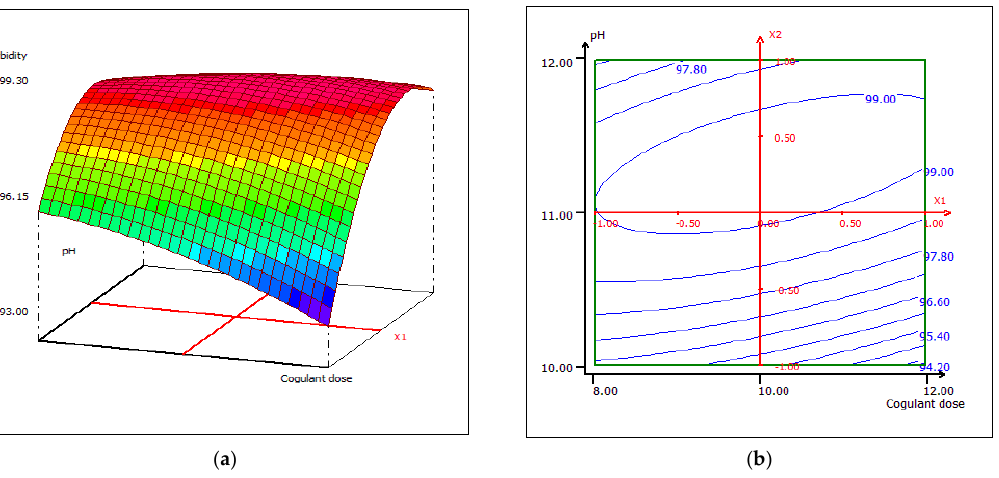
Figure 17. Three-dimensional ( a ) and two-dimensional ( b ) response surface plots for the turbidity of the treated food processing wastewater using β-chitin extract as a function of coagulant dose and pH, when the temperature was maintained at 23 °C.